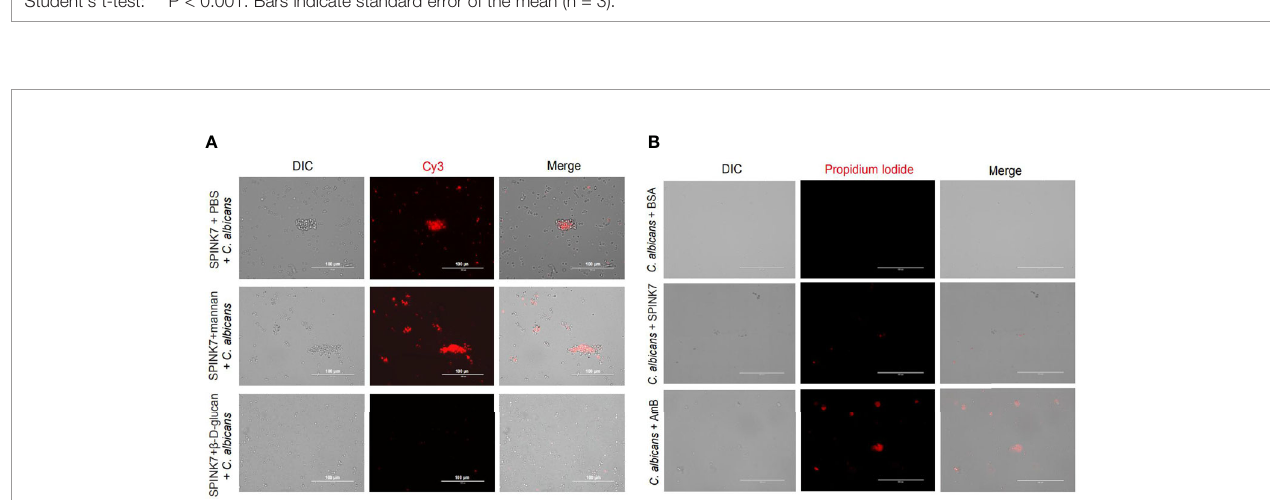
FIGURE 7 | Interaction between SPINK7 and C. albicans . (A) Immuno fl uorescence visualization of SPINK7 binding to C. albicans . SPINK7 was preincubated with PBS, mannan, and b -D-glucan, respectively, and then incubated with C. albicans spores. Slides were then incubated with anti-SPINK7 antibodies followed by a secondary antibody labeled with Cy3 (red). (B) Photomicrographs of C. albicans stained with propidium iodide after treatment with amphotericin B (AmB) or BSA or SPINK7. Red (propidium iodide) indicates cells with ruptured